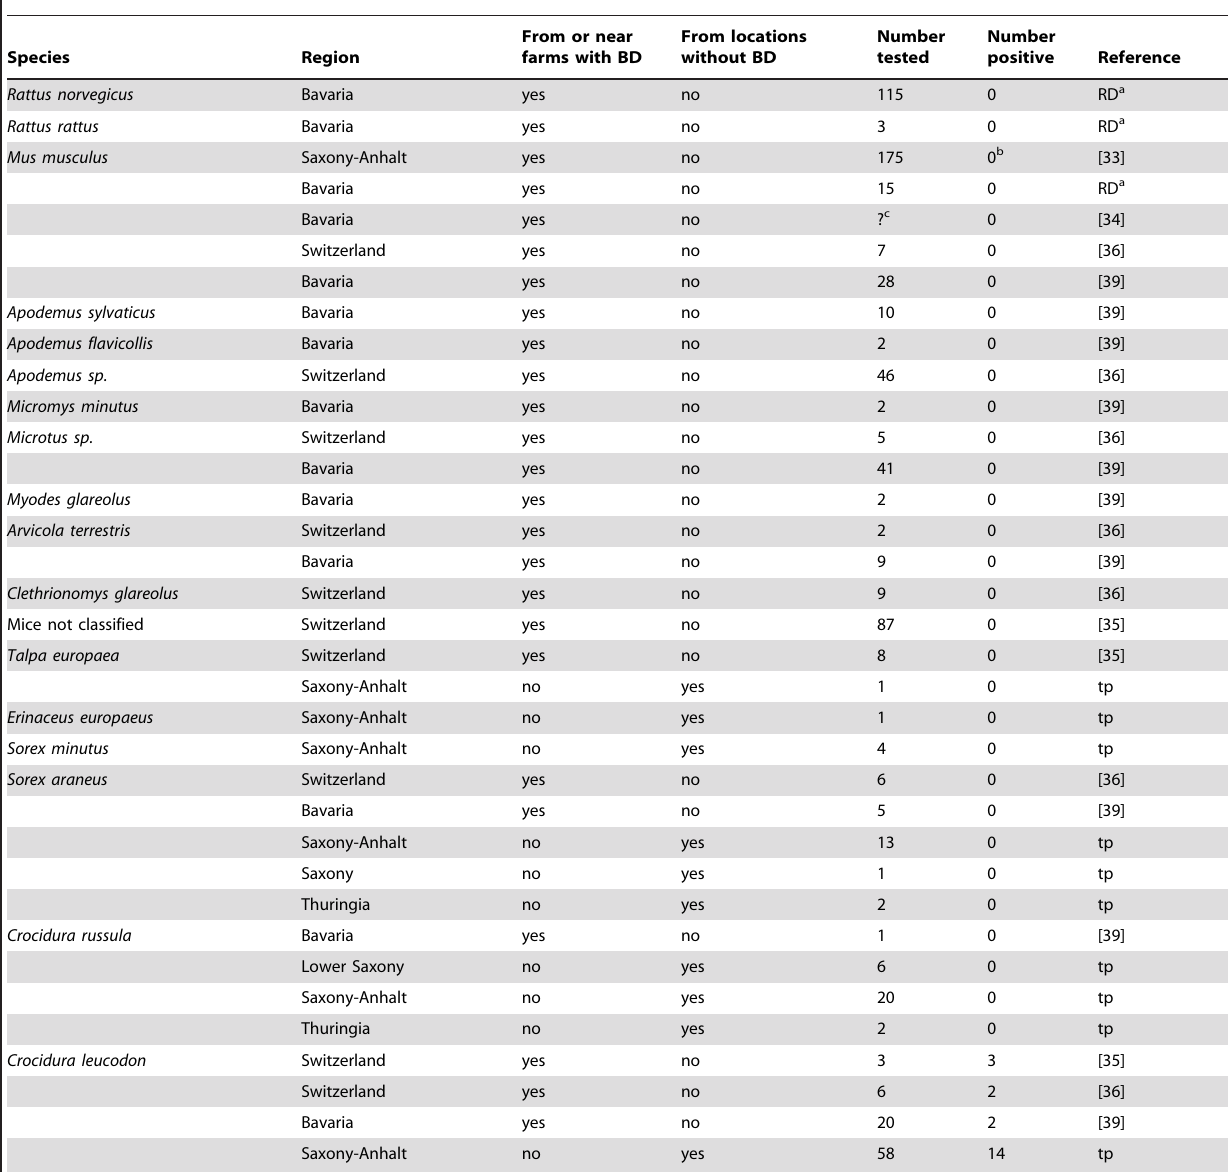
Table 3. Overview of potential reservoir species investigated in BD endemic regions so far.